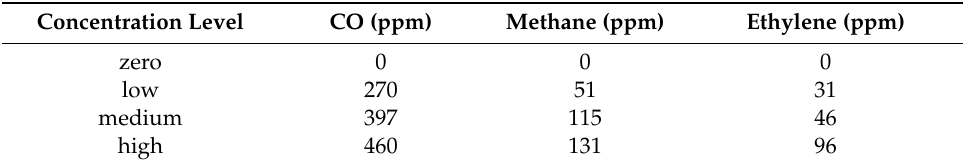
Table 4. Average concentration levels of three